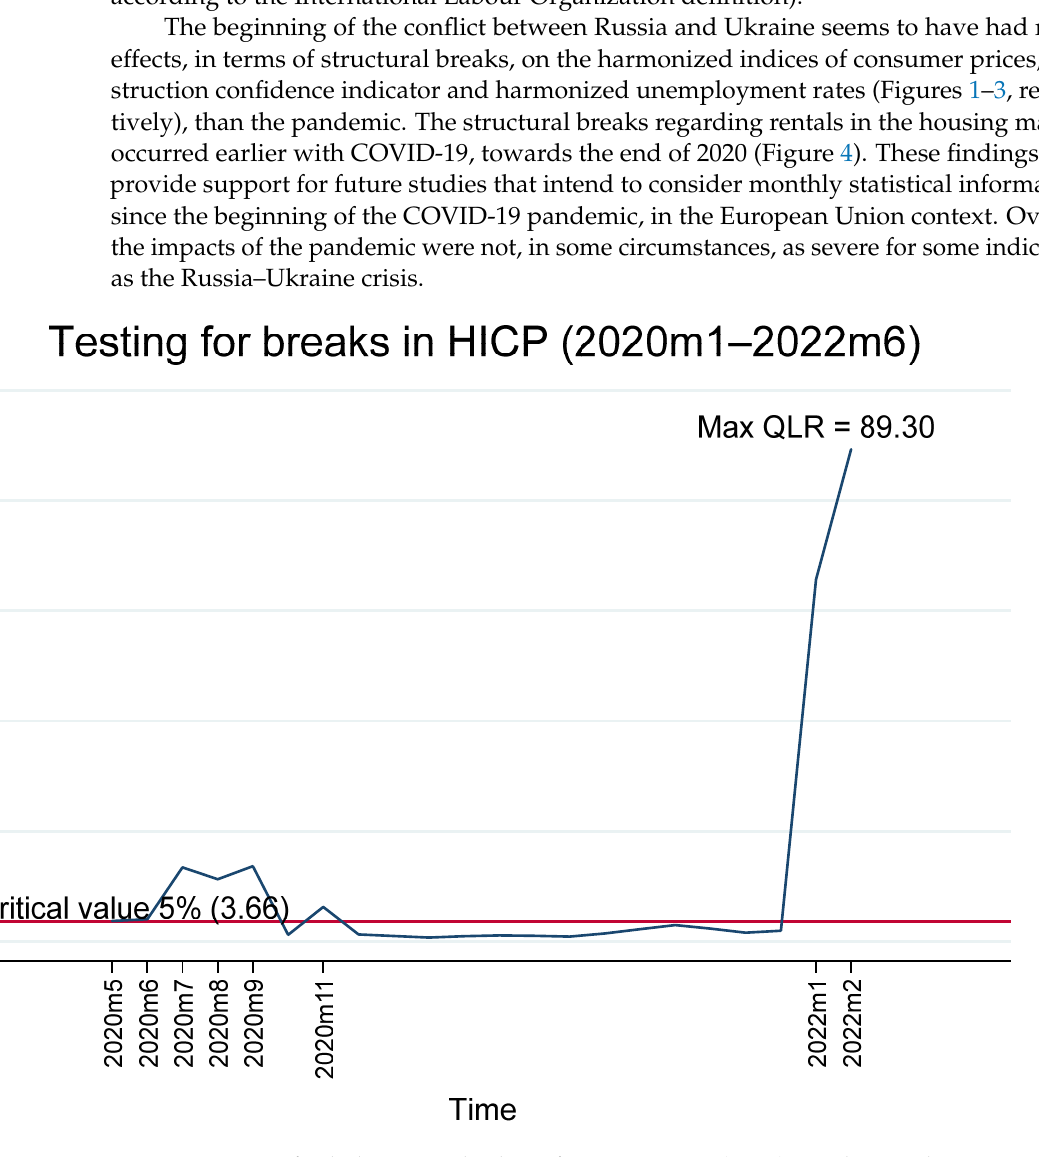
Figure 1. QLR test for the harmonized indices of consumer prices (HICP) over the period 2020m1– 2022m6.